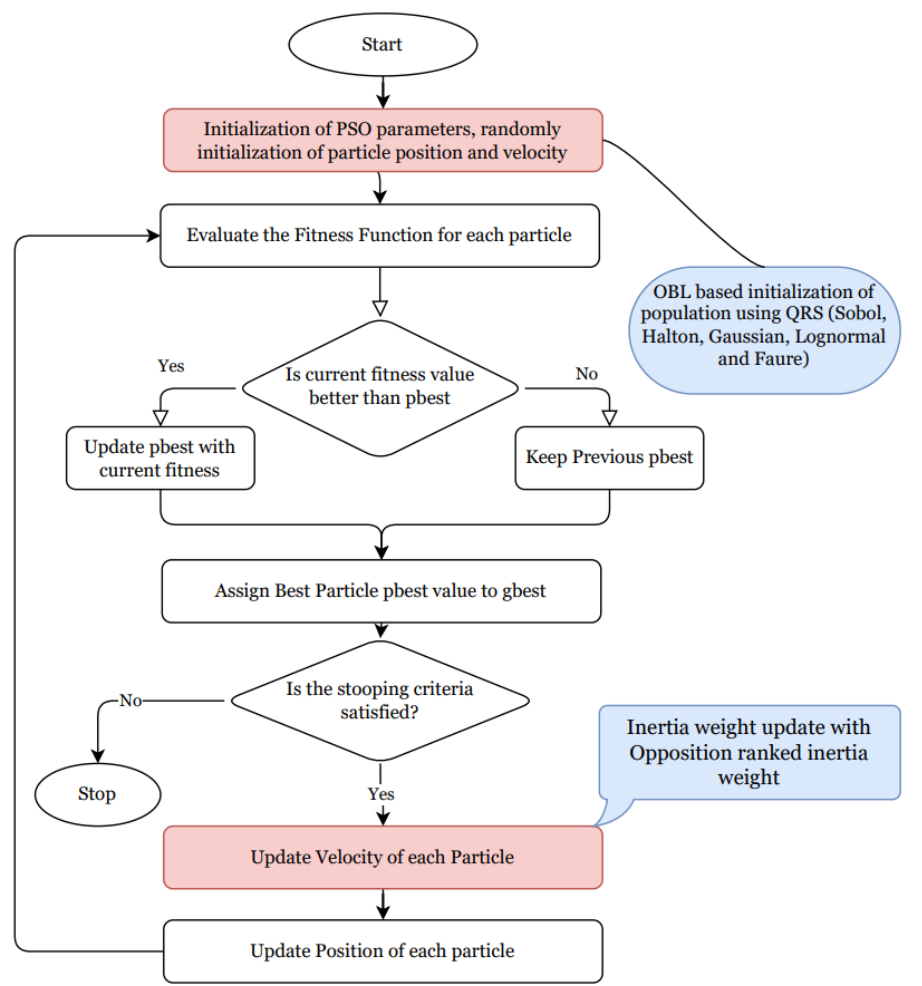
Figure 1. Proposed